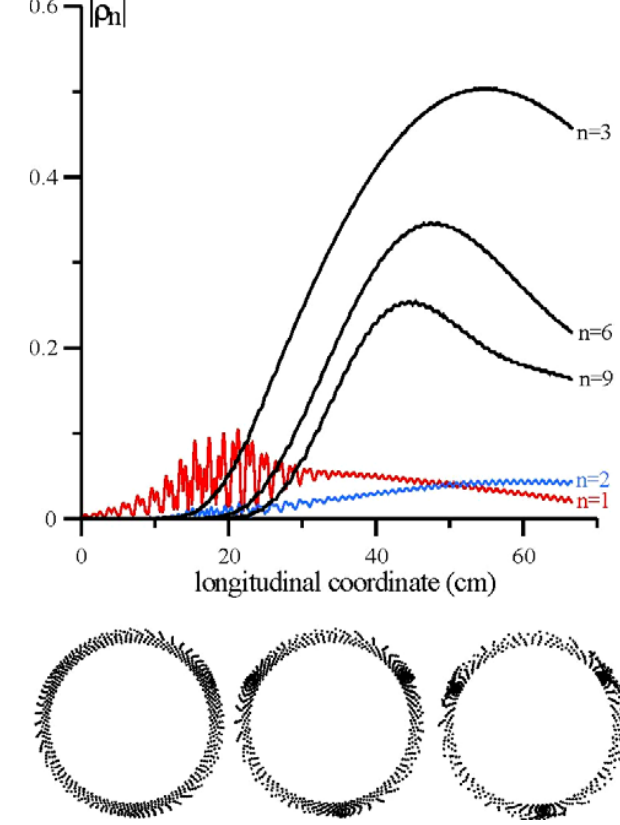
FIG. 5. (Color) Frequency doubling: operating (black curves) and spurious (color curves) harmonics of the electron current (cid:3) versus the longitudinal coordinate and distribution of electrons over their gyrophases and Larmor radii for the case of 15% velocity spread.